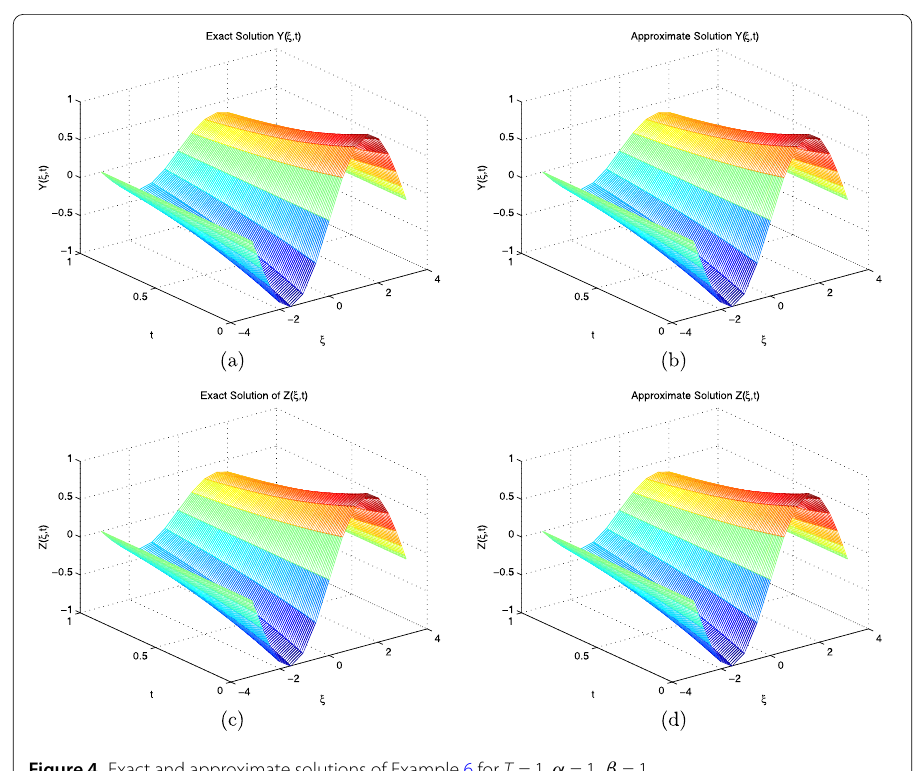
Figure 4 Exact and approximate solutions of Example 6 for T = 1, α = 1, β = 1